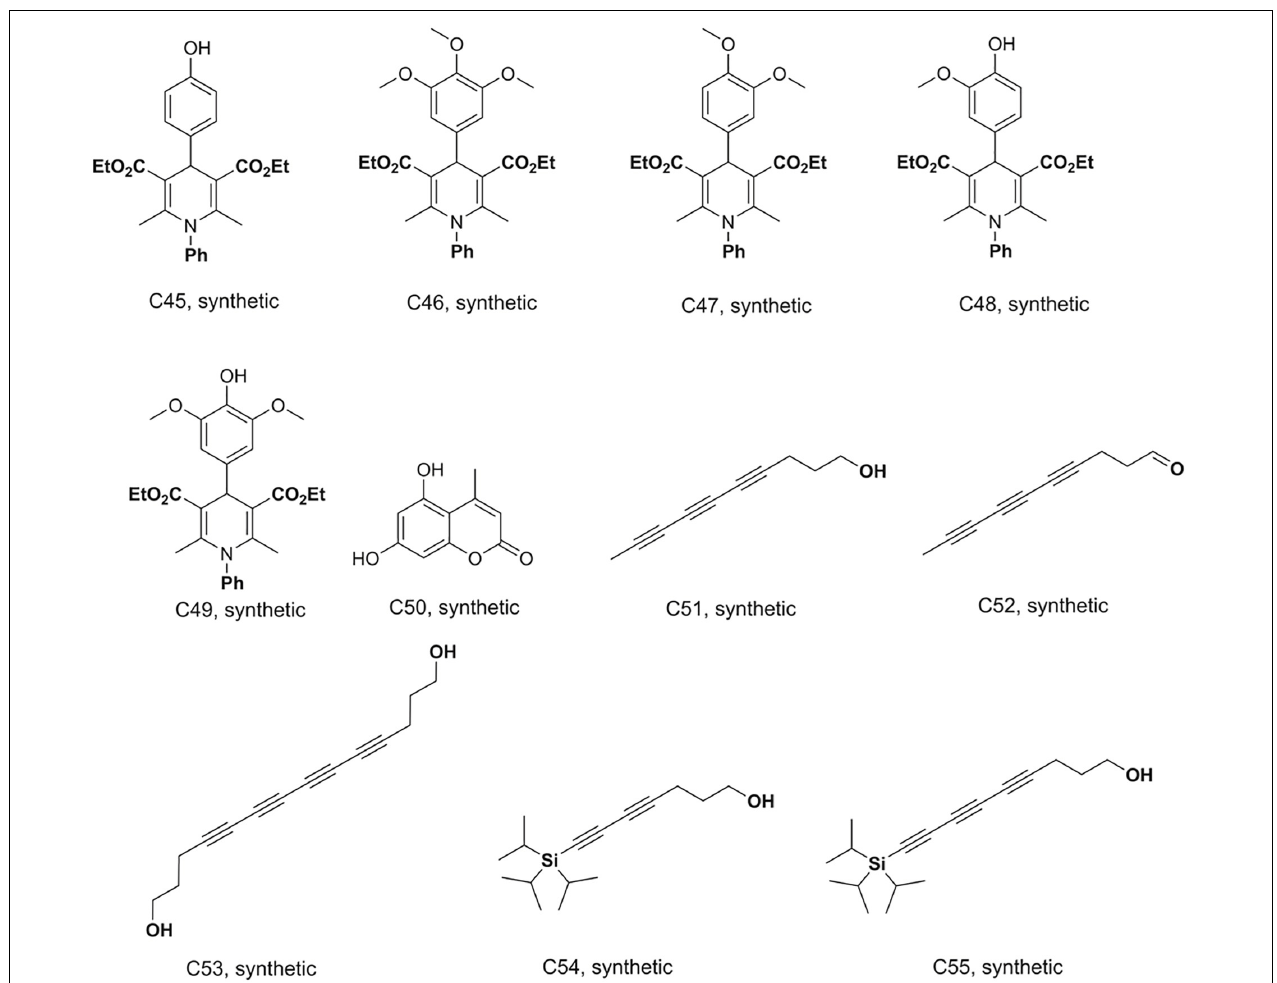
FIGURE 4 | Structures of the compounds tested for anti -M. tuberculosis activity: Dihydropyridines C45–C49, coumarin C50, and polyacetylenes C51–C55 (Sandjo et al., 2016a; Pollo et al., 2017; Machado et al., 2018; Martin et al.,